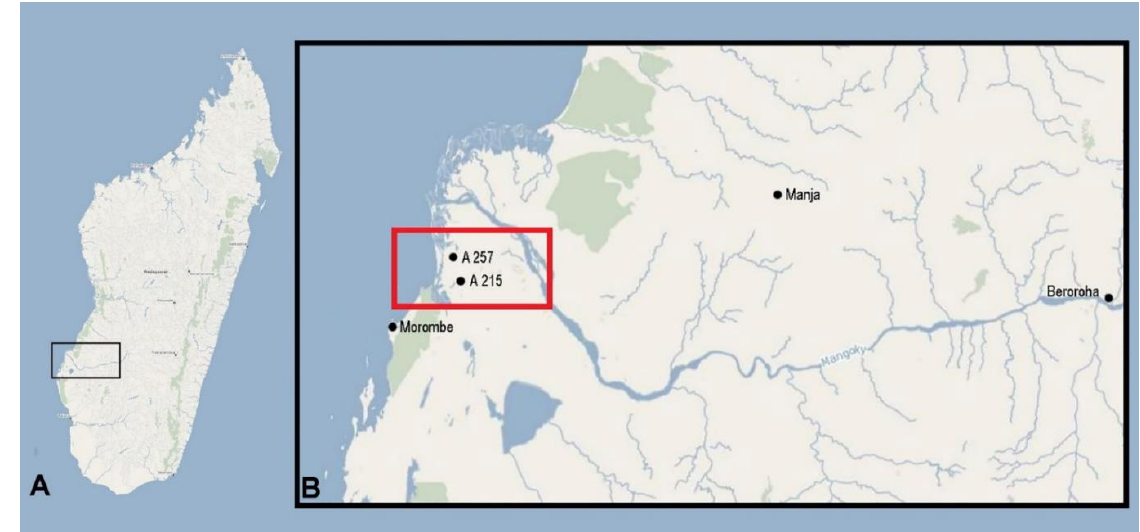
Figure 1. Map of Madagascar ( A ) with a detail of the investigated area, showing also the positions of the two baobabs in the red square ( B ).